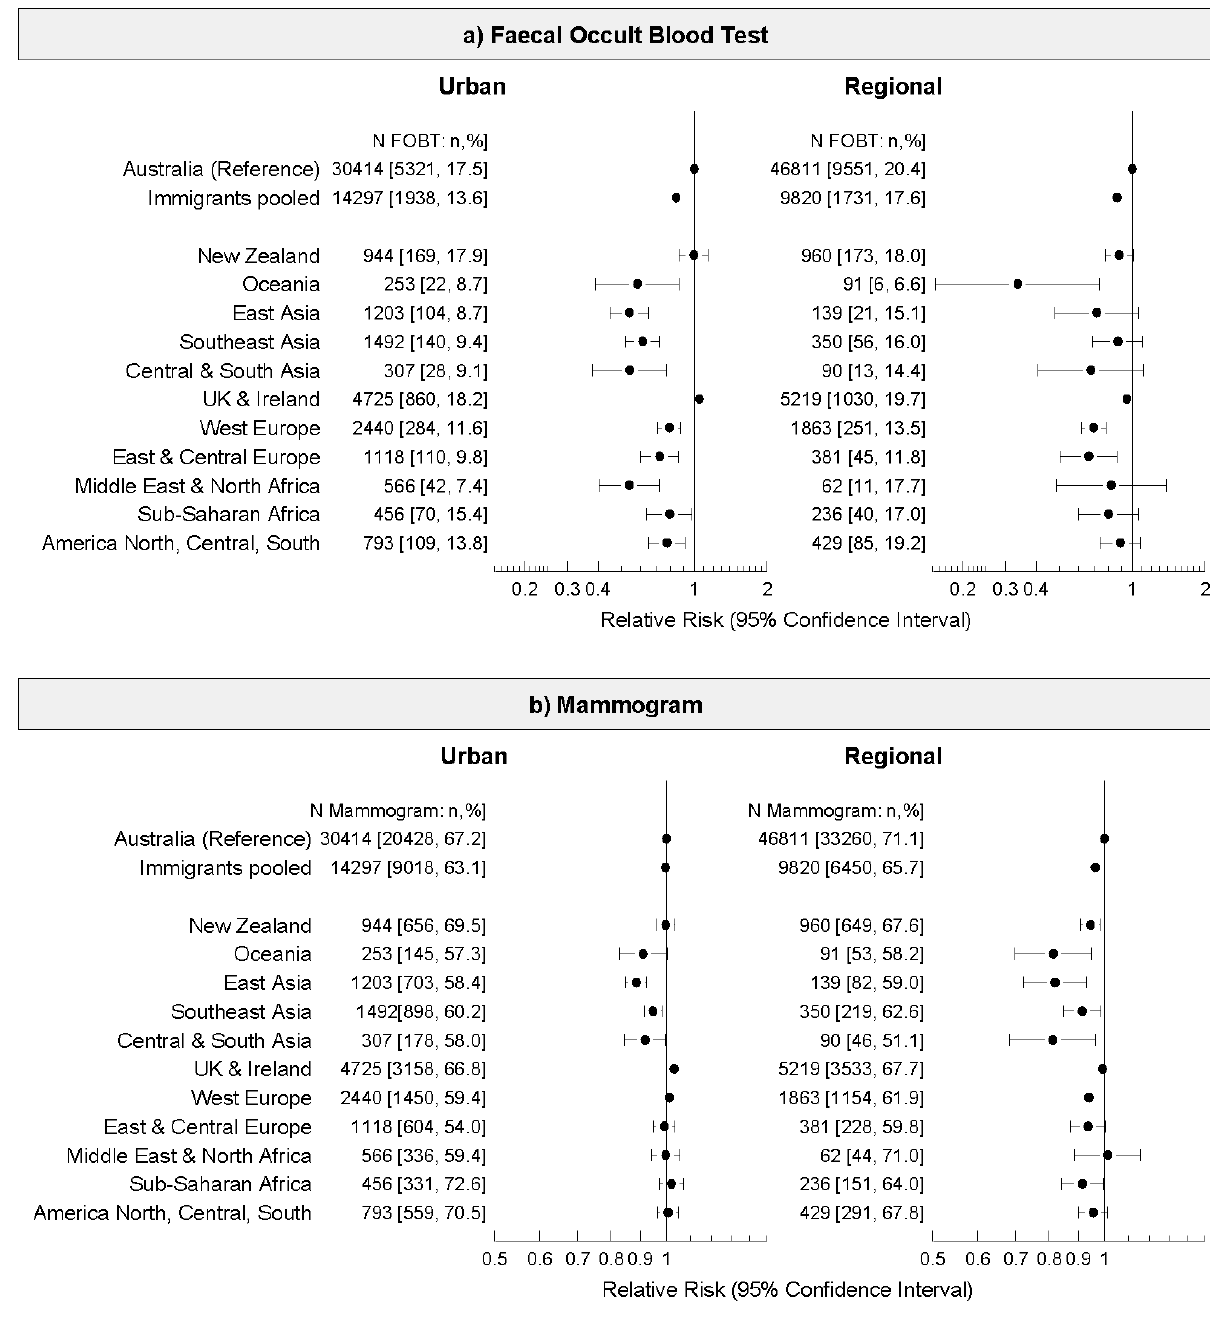
Figure 2. Relative risks and 95% confidence intervals of ( a ) faecal occult blood test (FOBT), and ( b ) mammogram use, in the last two years among women living in urban and regional areas of New South Wales, Australia by place of birth in the 45 and Up Study (2006–2010). Relative risks adjusted for age, family history of any cancer type, education, income, health insurance status, relationship status, retirement status, and hormone replacement